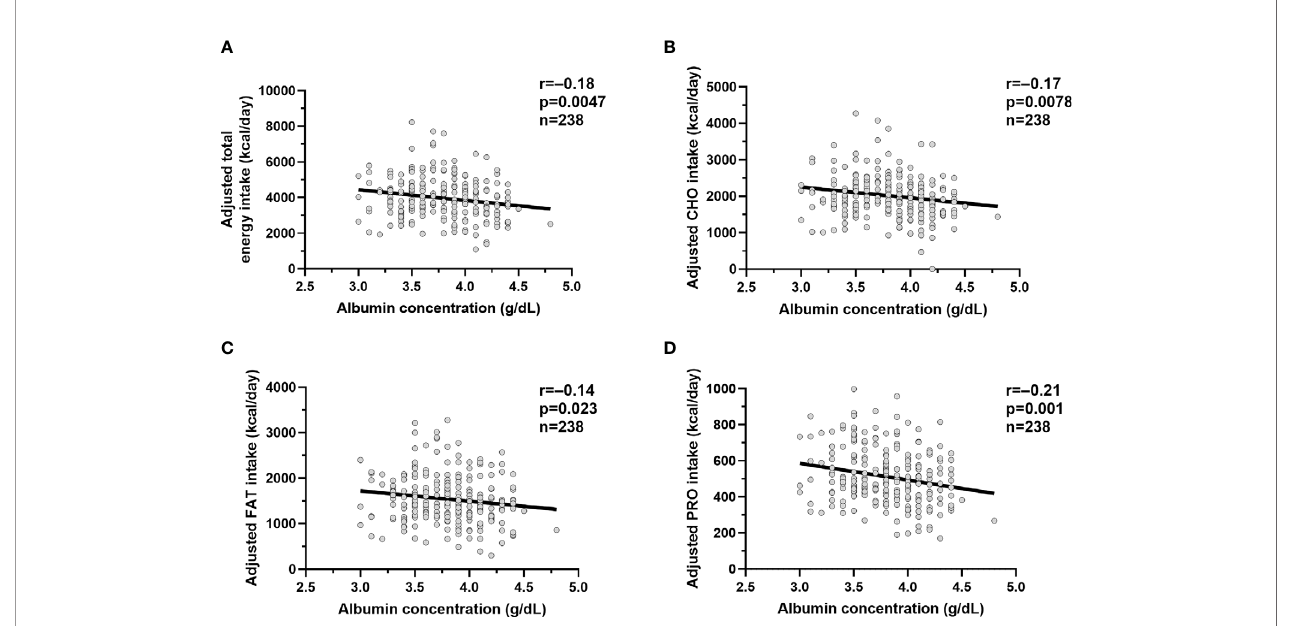
FIGURE 2 | Relationships between albumin concentrations and ad libitum food intake measures. Relationships between plasma albumin concentration (g/dl) and adjusted total ad libitum food intake (A) , adjusted carbohydrate intake (B) , adjusted fat intake (C) and adjusted protein intake (D) . The total ad libitum food intake and each macronutrient intake during the 3-day vending period are expressed as the average over 3 days. The adjusted food and macronutrient intake values were calculated via linear regression analysis including fat-free mass, fat mass, age, sex, ethnicity after adding the average total food and macronutrient intake to the residual values obtained from the regression model. In each panel, the Pearson ’ s correlation coef fi cient (r) is reported along with its signi fi cance